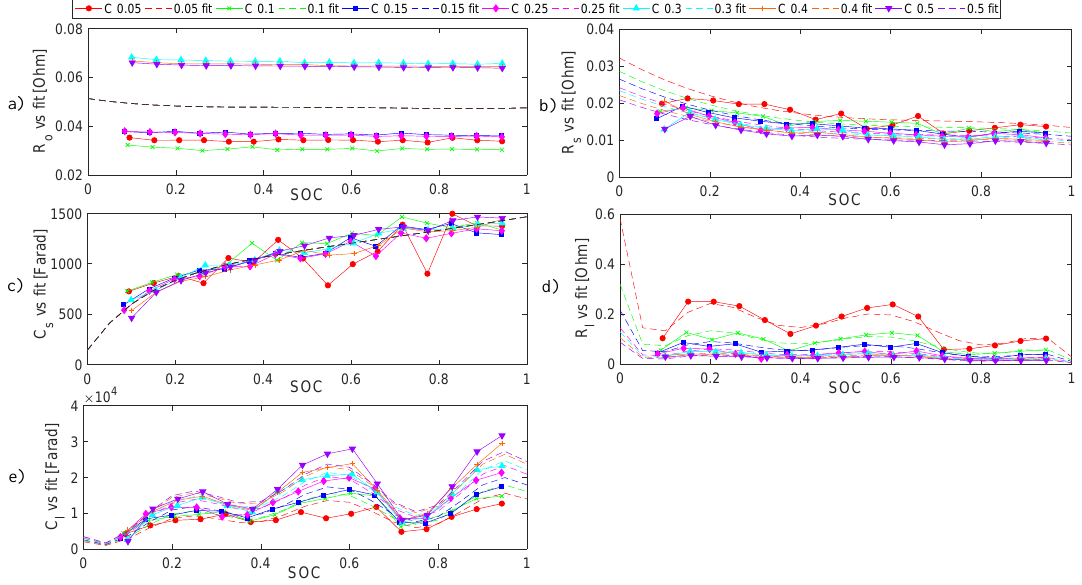
Figure 11. The values of RC elements and their fitted results: LFP batteries during discharge. From the results in Figure 10 and 11, some conclusions for LFP batteries can be drawn: 1. Except for R o , all other electrical elements show a strong dependency on SOC. 2. All electrical elements exhibit an inverse behaviour versus SOC in charge and discharge. 3. The operational current influences R s , R l and C l in both charge and discharge